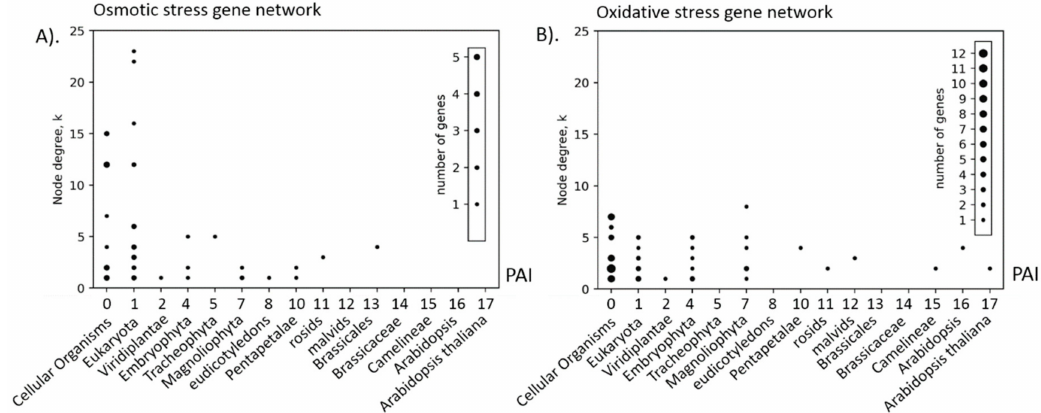
Figure 5. The PAI versus k scatterplots for osmotic ( A ) and oxidative ( B ) stress gene networks. The X-axis represents the PAI, the Y-axis shows node degree k